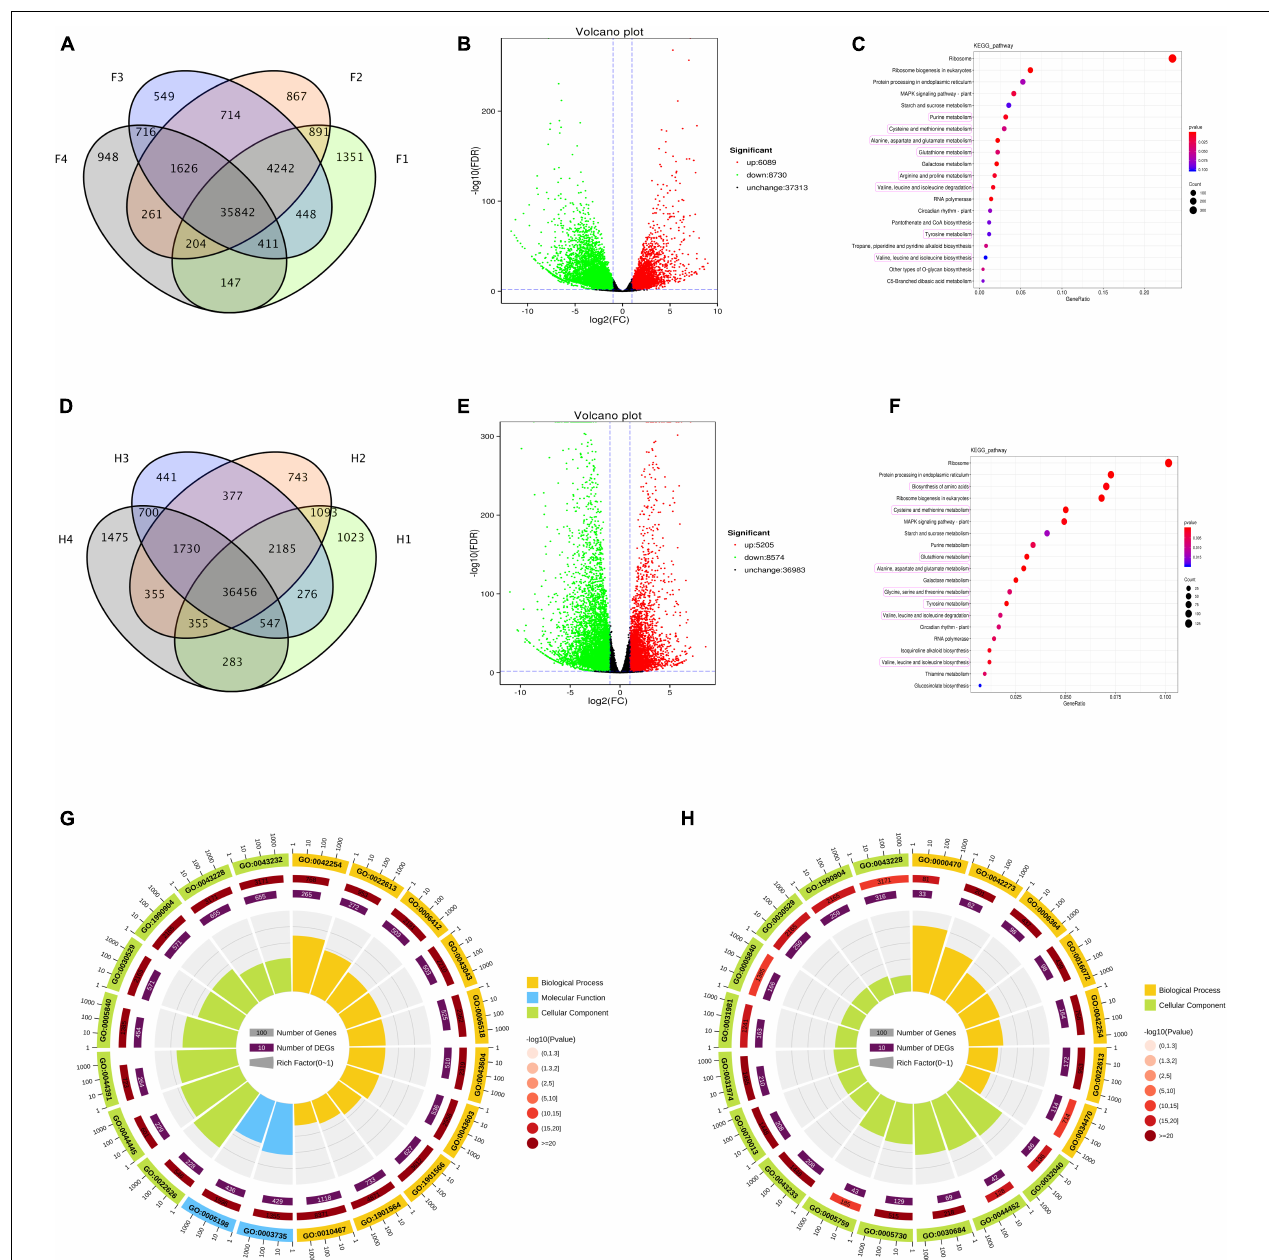
FIGURE 3 | Analysis of differentially expressed genes (DEGs) in Zanthoxylum bungeanum leaves under drought stress. (A,D) Venn diagram of unigenes expressed at four drought stages in FJ and HJ, respectively. (B,E) Volcano plot of DEGs in FJ and HJ, respectively. Red dots indicating the upregulated genes, green dots indicating the downregulated genes, and black dots indicating the genes with no significant change. (C,F) Kyoto encyclopedia of genes and genomes (KEGG) enrichment bubble diagrams of DEGs in FJ and HJ, respectively. Bubble size indicating the number of DEGs enriched in this KEGG pathway; bubble color indicating the P values. (G,H) GO enrichment circle diagram of DEGs in FJ and HJ leaves, respectively. The outside lap represents the top 20 GO terms; the mid lap represents the numbers of all genes in GO terms and P values for gene enrichment for the specified GO term; and the inner lap represents the numbers of DEGs. The ladder column in the center represents the Rich factor of DEGs for each GO